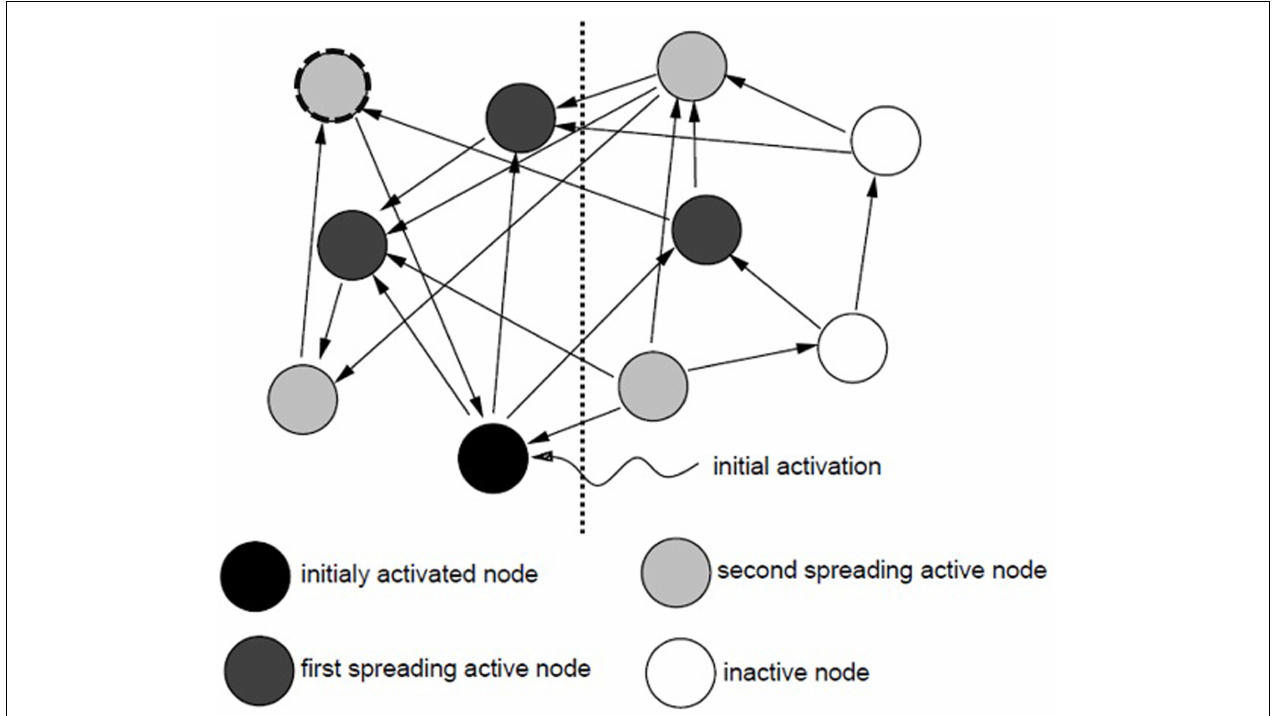
FIGURE 1 | The spread of activation through a memory network (adapted from Crestani,